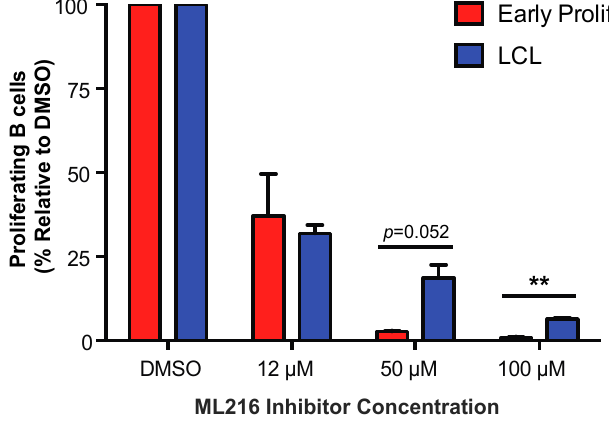
Figure 4. Early proliferating EBV-infected B cells are more sensitive to BLM helicase inhibition than LCLs. Percentage of proliferating CD19+ B cells was determined for early proliferating EBV-infected B cells (red) and LCLs (blue) that were treated with DMSO or with 12 µM, 50 µM, or 100 µM ML216 BLM helicase inhibitor at the time of infection. The data were analyzed by FACS at day 7 post-infection. Error bars represent S.E.M. of three independent donors. ** p < 0.01 as determined by a Student’s t -test.